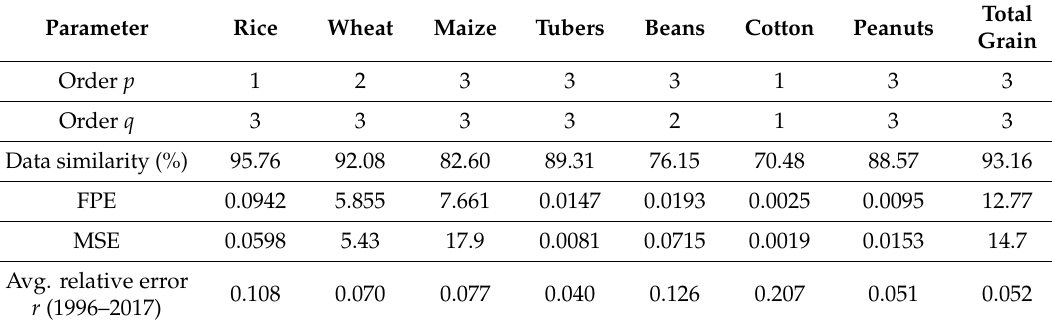
Table 6. Prediction results on crop yields using the ARMA